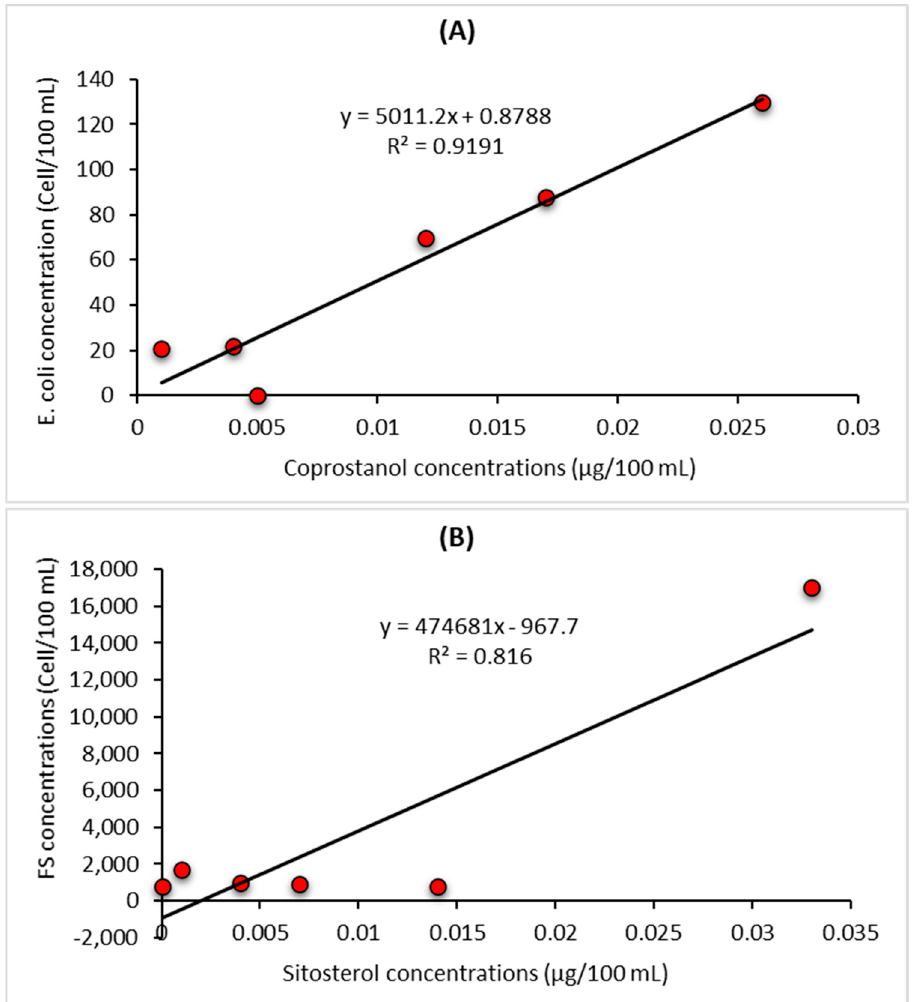
Figure 6. ( A ). Linear regression of E. coli (numbers per 100 mL) and coprostanol ( µ g 100 mL) in water samples. ( B ). Linear regression of Faecal Streptococci (numbers per 100 mL) and sitosterol ( µ g 100 mL) in